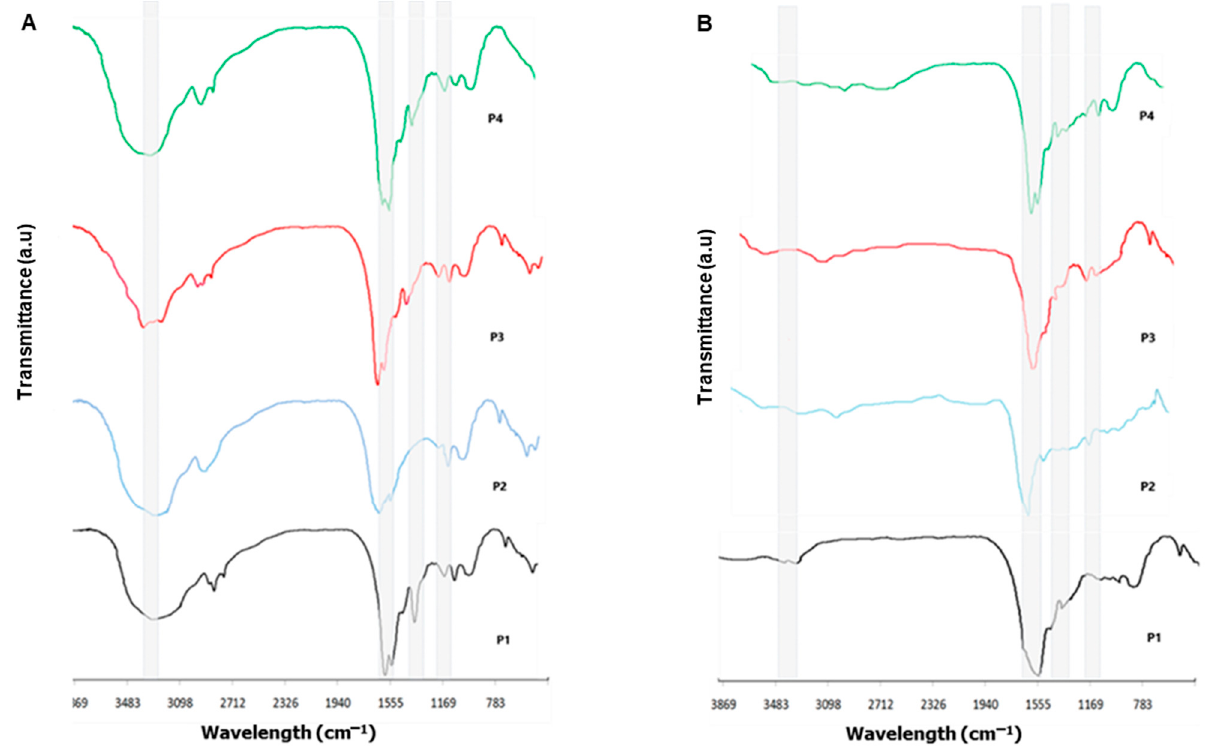
Figure 3. Organic compounds demonstrated by Fourier transform infrared spectra (FTIR) of extracts from marine sponge species ( A ) C. caribensis ( B ) A. fulva.